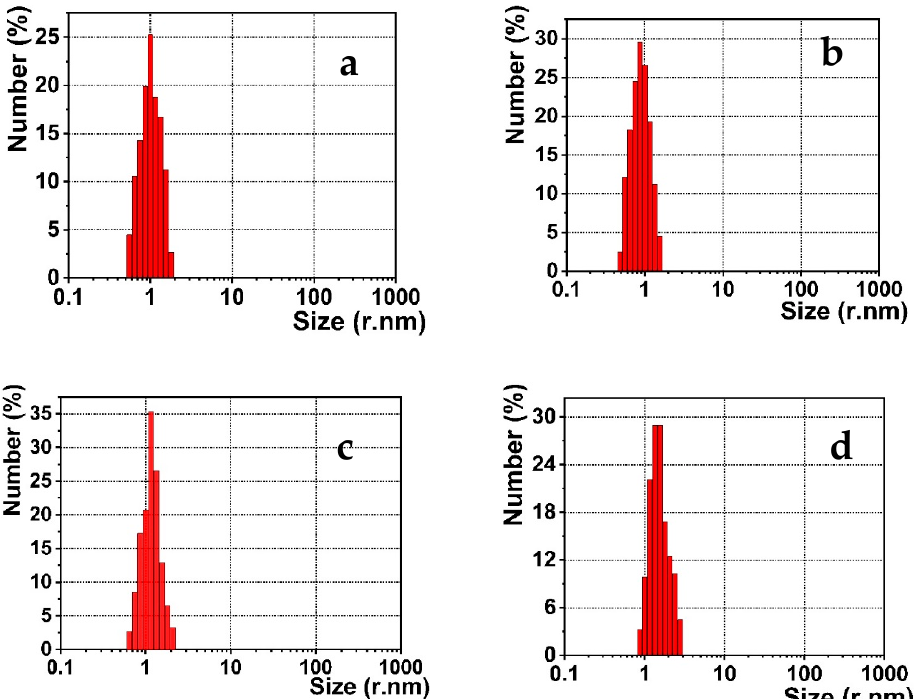
Figure 6. DLS data of Tryp-AgNCs in the presence of ( a ) 0.05; ( b ) 1.5; ( c ) 3.0; and ( d ) 6.0 µM Fe(III).